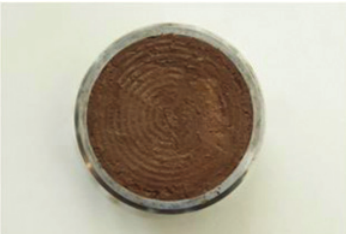
Fig. 1. Clay sample after filtration (top